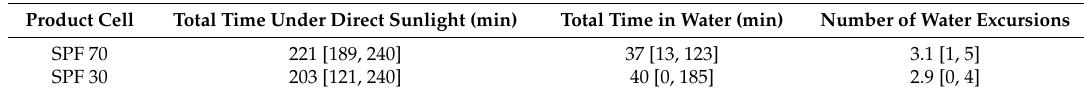
Table 2. Application amount and surface density (mean ± standard deviation).